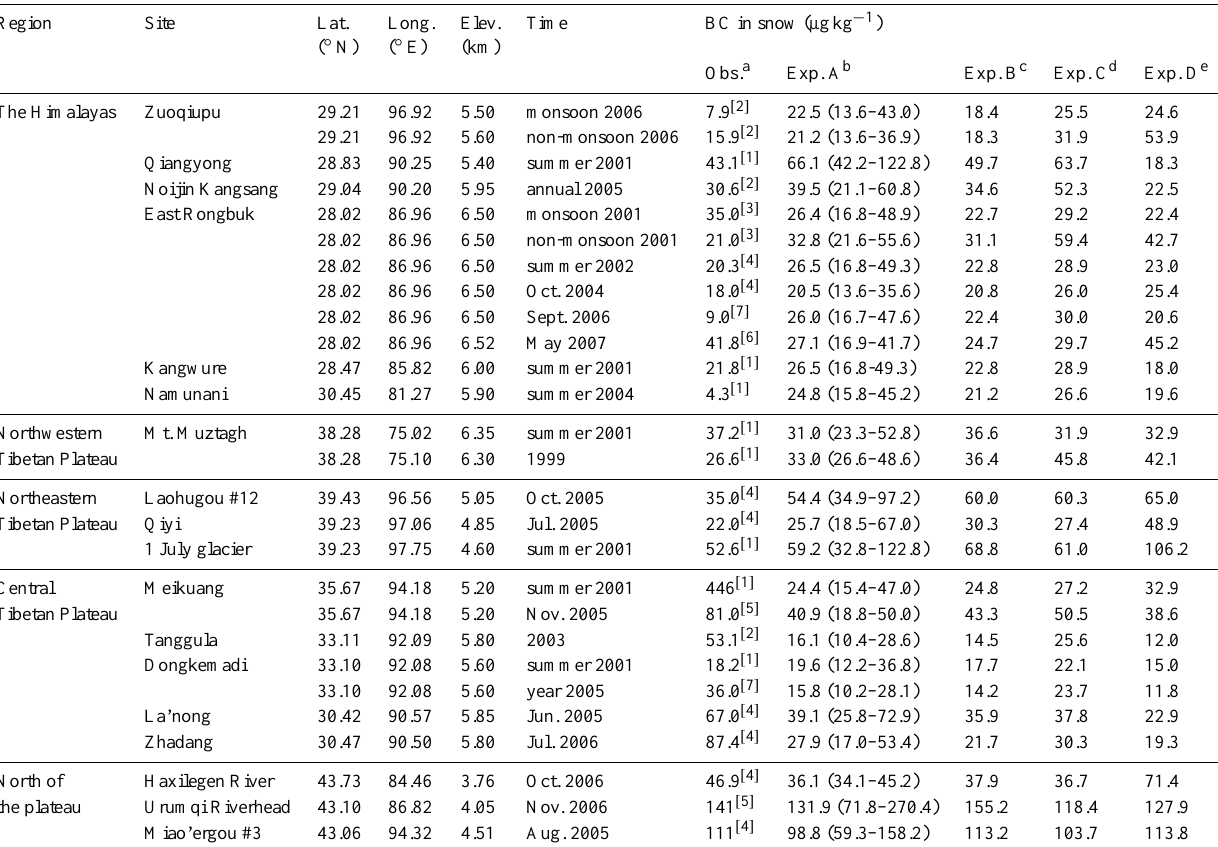
Table 2. Observed and simulated BC concentrations in snow over the Tibetan Plateau (see also Fig. 1). Region Site